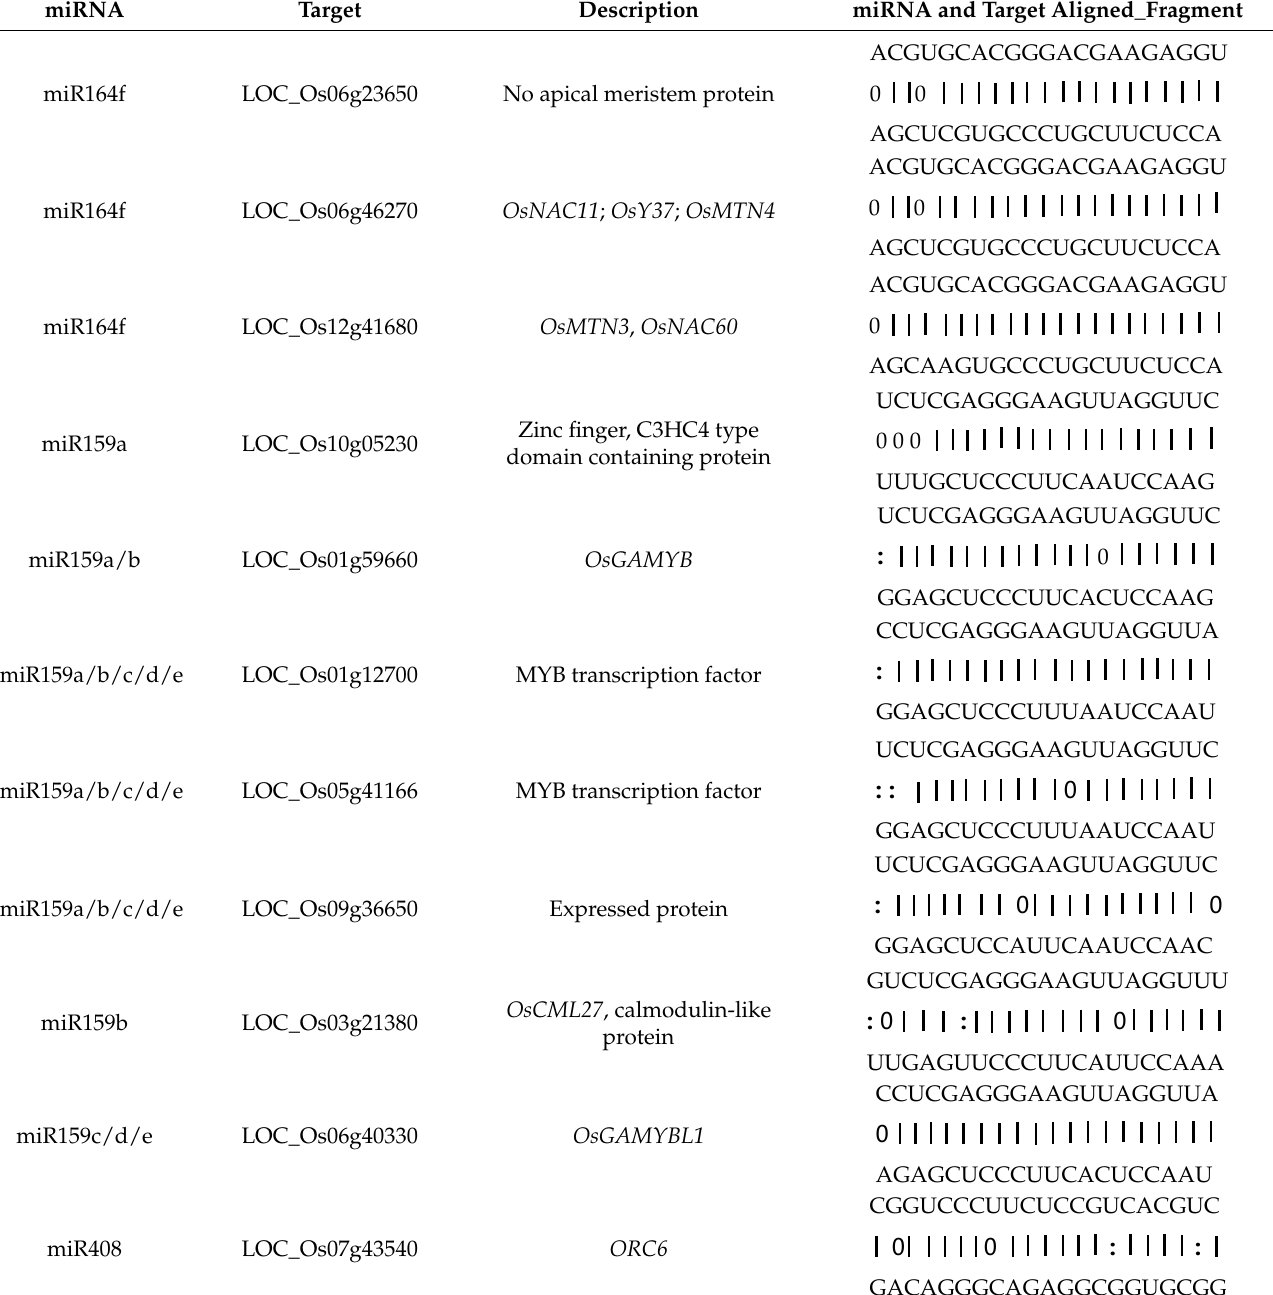
Table 1. Predicted target genes of miRNA164, -159, and -408. Inhibition: cleavage.